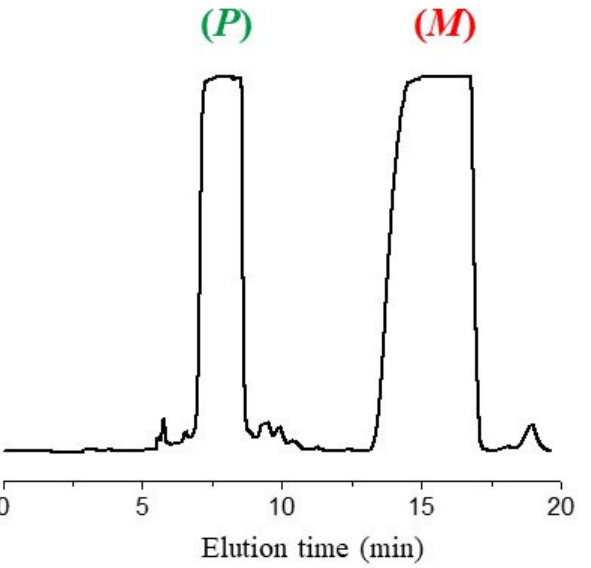
Figure 5. Optimized semipreparative HPLC resolution of 5.2 mg of BT2 – T6 . Chromatographic conditions: column, Chiralpak IB (250 mm × 10 mm, 5 µ m); mobile phase, n -hexane–methanol– dichloromethane 90:5:5 ( v / v / v ); column temperature, 15 ◦ C; flow rate, 5.5 mL min − 1 ; detection, UV at 360 nm.